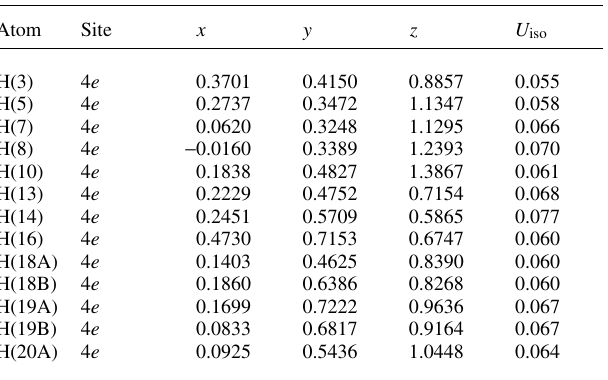
Table 2. Atomic coordinates and displacement parameters (in Å 2 )